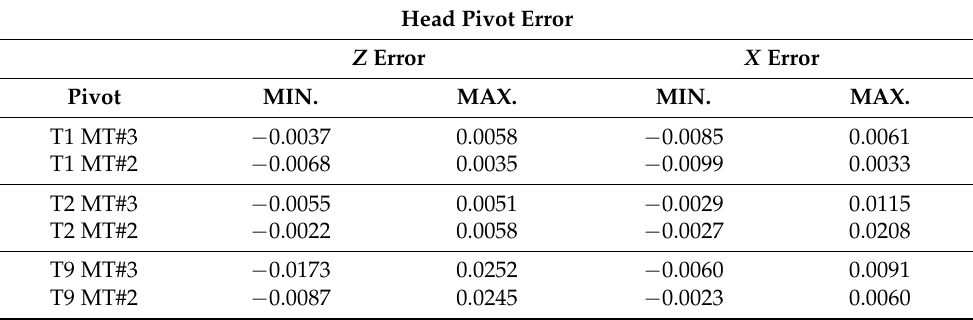
Table 9. Summary of results for Z - and X -axes pivot point error analysis for the probes T1, T2, and T9 at B0 ◦ /B90 ◦ head position. Results in